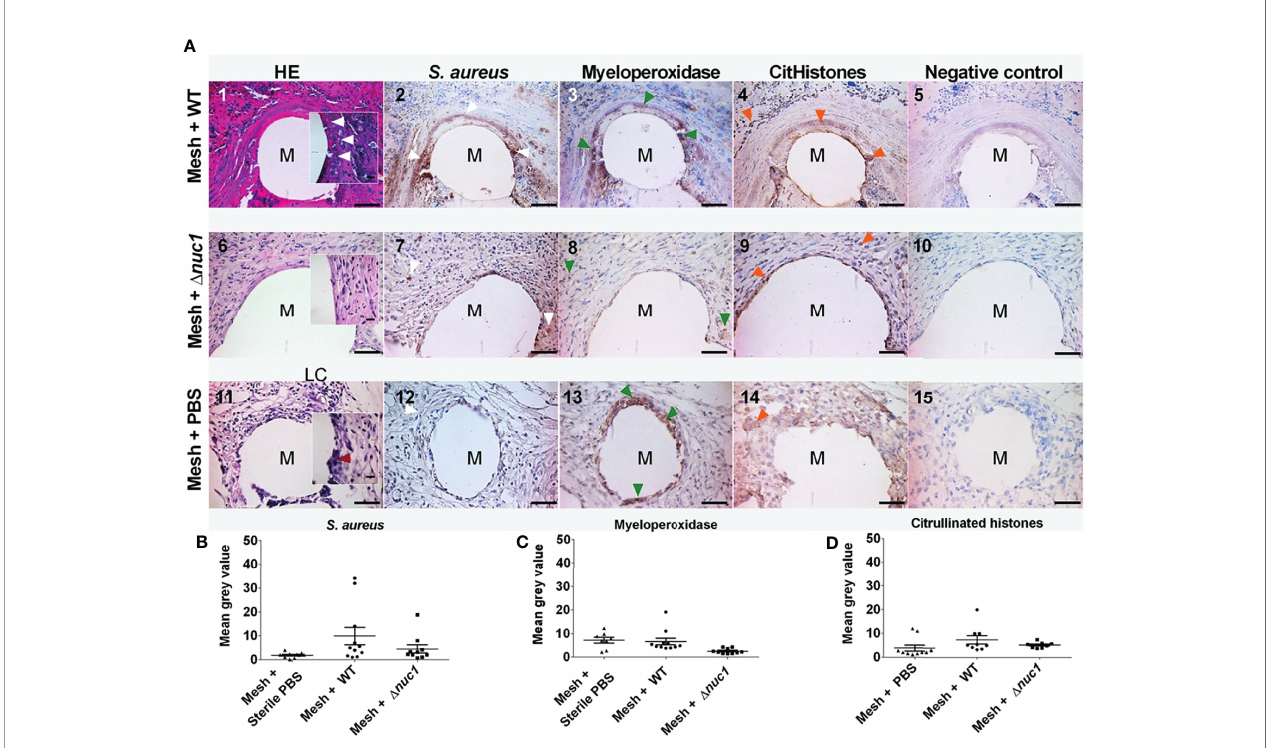
FIGURE 4 | (A) Representative images of hematoxylin (dark blue) and eosin (pink) staining and immune-histochemical detection (brown staining) hematoxylin of S. aureus , myeloperoxidase and citrullinated histones in mice tissue biopsies at positions surrounding a single fi lament of a PVDF surgical mesh implant (M) in combination with an S. aureus WT lux, S. aureus Newman D nuc1 lux or sterile PBS injection. Biopsies were taken from mice terminated 12 and 13 days after implantation. Each image in a row corresponds to the same location in the sample taken from one mouse. White arrowheads show locations of bacterial bio fi lms, dark red arrowheads show locations of foreign body giant cells, green arrowheads show locations of myeloperoxidase and orange arrowheads show locations of citrullinated histones (CitHistones). As a negative control for each antibody staining, primary antibody was replaced with equal amounts of antibody diluent. (B) Semi- quantitative analysis of immunohistochemically determined S. aureus , (C) , myeloperoxidase and (D) citrullinated histones. Data points represent data from tissue from 2 different mice per group of infected mice and 3 in the group of sterile mice and 4 fi laments from each mouse were analyzed except when only 1 fi lament was present in a single biopsy. Error bars show the standard error of the mean.